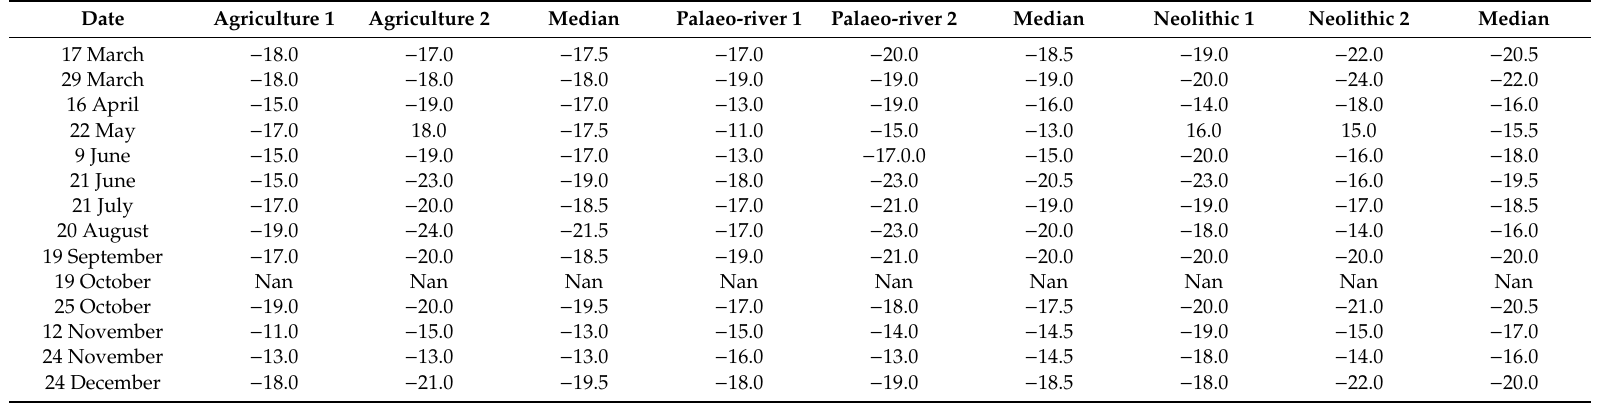
Table A2. Backscatter values for the Sentinel 1 2019 Sigma0-VH ascending pass